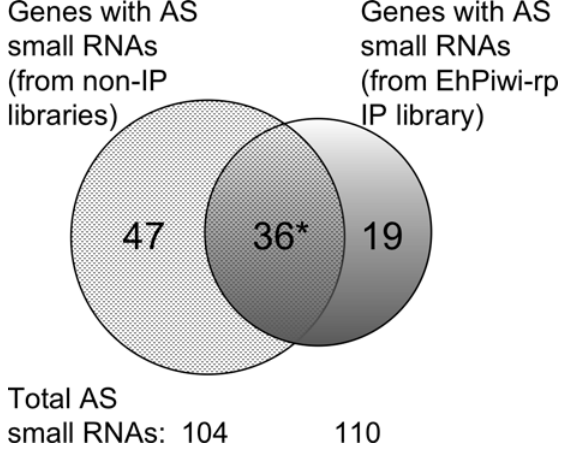
Figure 5. Overlap in genes targeted by antisense small RNAs in small RNA libraries made from non-immunoprecipitated and immunoprecipitated material. Of the 83 genes to which antisense small RNAs map, 36 genes were also targeted by antisense small RNAs from the Myc-EhPiwi-rp immunoprecipitated sample (p=1.7e 2 61 ). * Three small RNAs cloned from the non-IP and IP libraries were highly similar (few nucleotide mismatch at the 5 9 or 3 9 -termini of the small